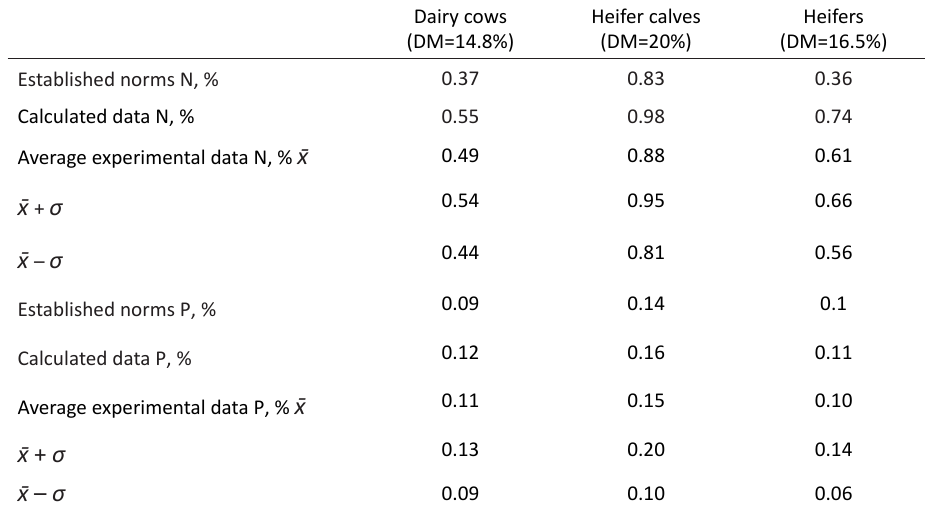
Table 4. Total nitrogen and phosphorus content in cattle manure at ex animal level (fresh manure)